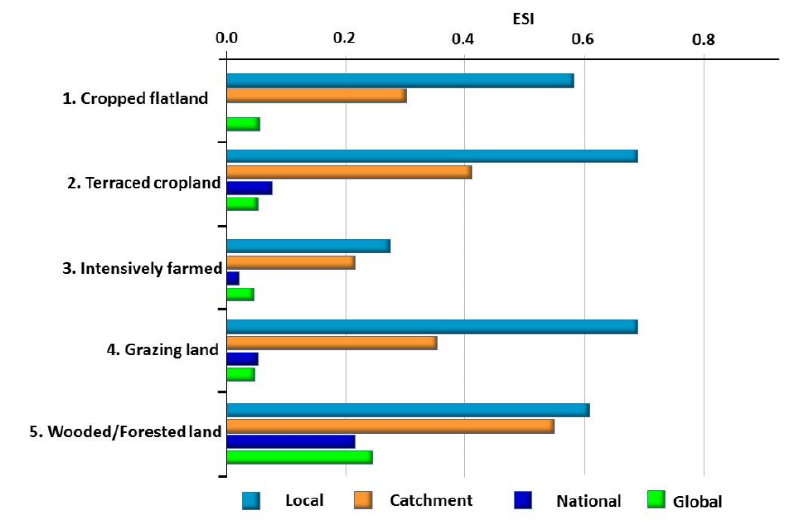
Figure 5. Ecosystem service index (ESI) for the five major land use types in rural and peri-urban areas, ranked according to the contribution at global, national, catchment and local levels.